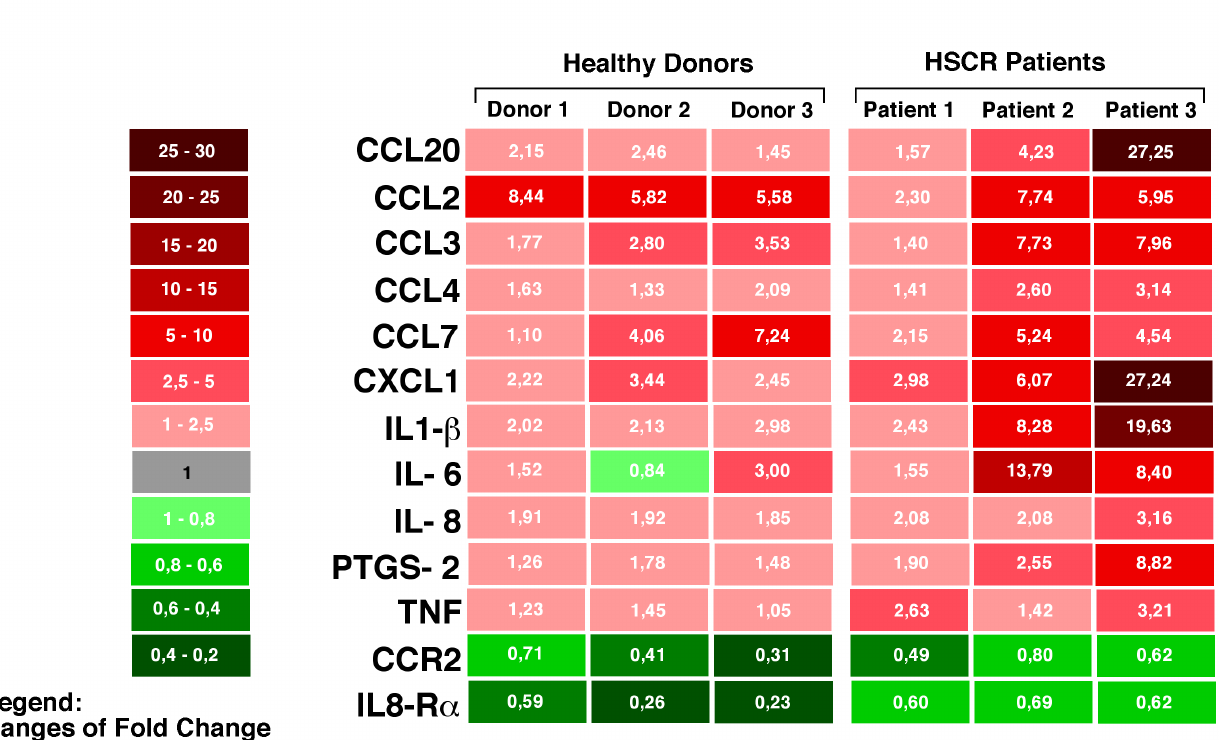
Figure 5. Modulation of RET-dependent genes. Colorimetric scale graph showing the fold increase (red) and decrease (green) of mRNA transcripts for those genes modulated in both PBMCs from healthy donors and HSCR patients following treatment with GDNF and GFR a 1. The differences in fold changes of RET-dependent genes between the PBMCs of three healthy donors and three HSCR patients analyzed are indicated by means of 2 2 DD Ct values included in each square and by the ranges of color tonality of the same square.